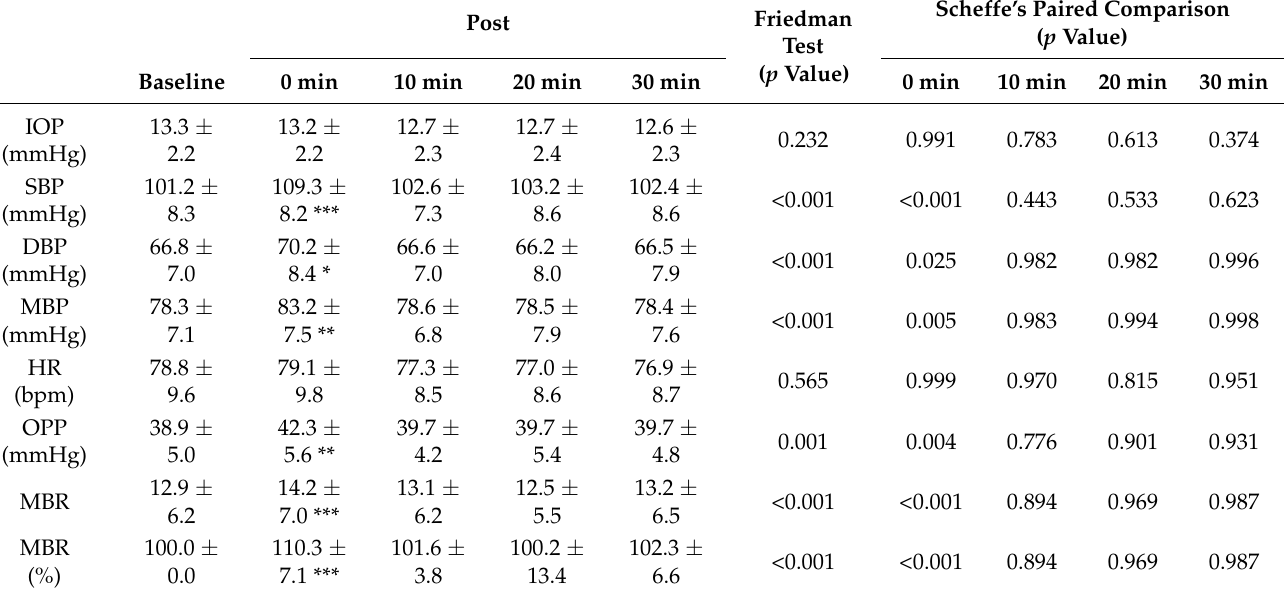
Table 1. Changes in ocular biometric parameters and systemic factors at baseline and after the cold pressor tests. Scheffe’s Paired Post Friedman Test ( p Value)